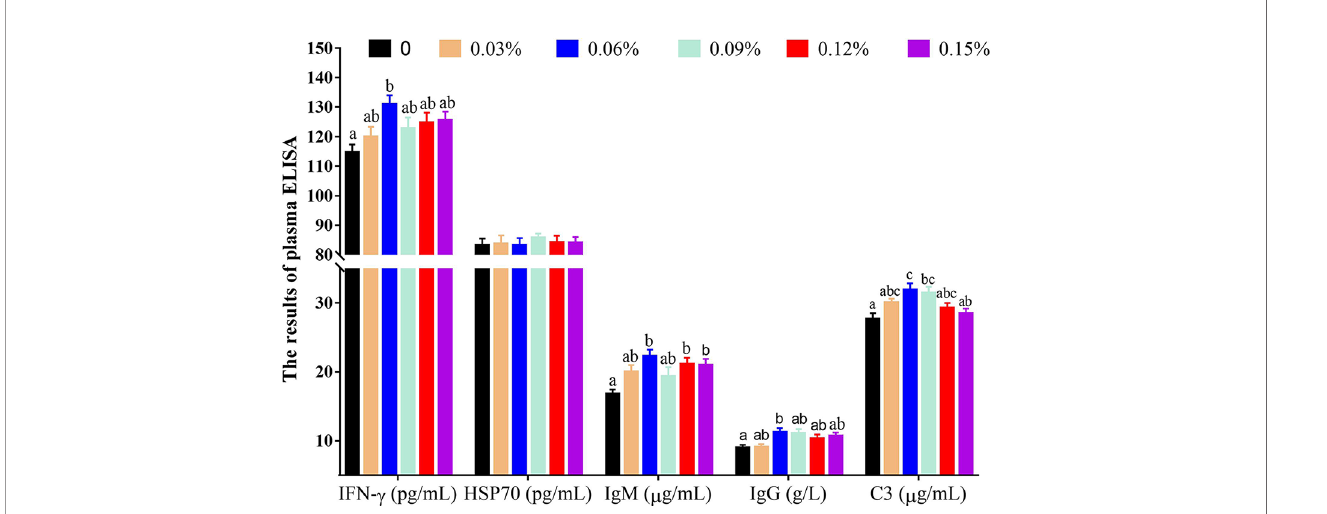
FIGURE 2 | The contents of plasma immune factors with different levels of TB supplementation. IFN- g , interferon- g ; HSP70, heat stress protein 70; IgM, immunoglobulin M; IgG, immunoglobulin G; C3, complement component 3. Data are expressed as means with S.E. Value with different superscripts are signi fi cantly different (P < 0.05).